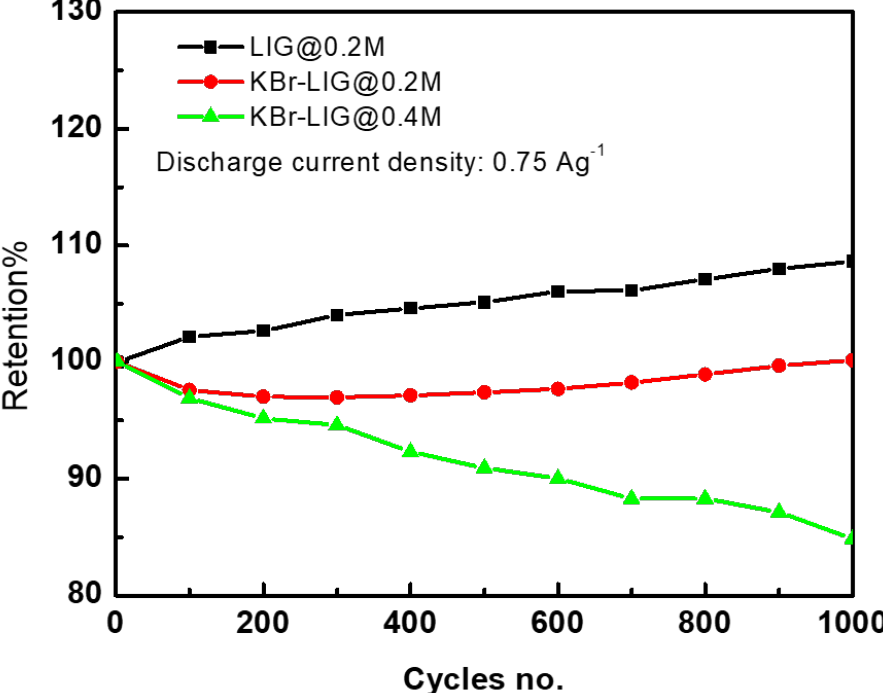
Figure 10. Cyclic stability for the specific capacitance retention at a discharge current density of 0.75 Ag −1